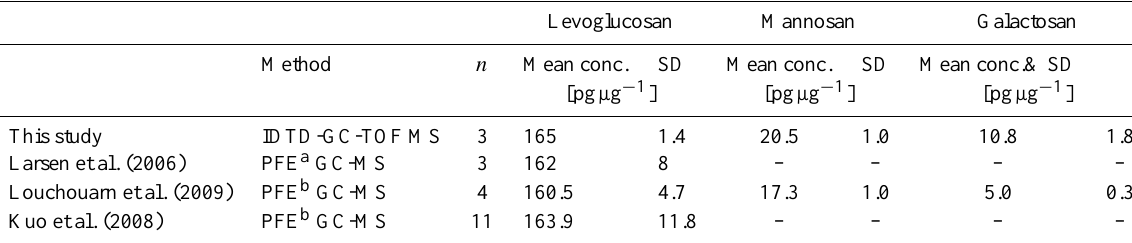
Table 3. Concentration of levoglucosan, mannosan and galactosan in NIST Standard Reference Material 1649a (Urban Dust). A comparison with other